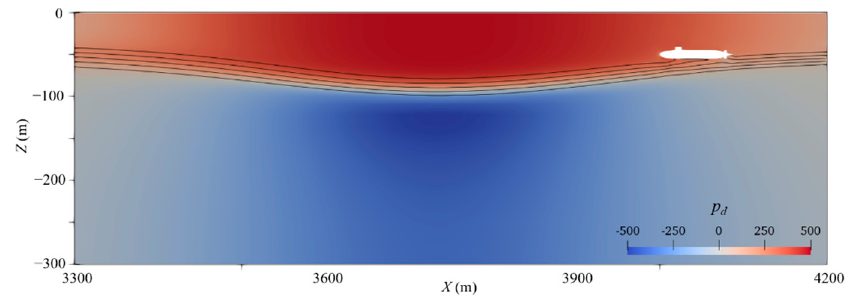
Figure 12. ISW-induced dynamic pressure ( p d ) field.